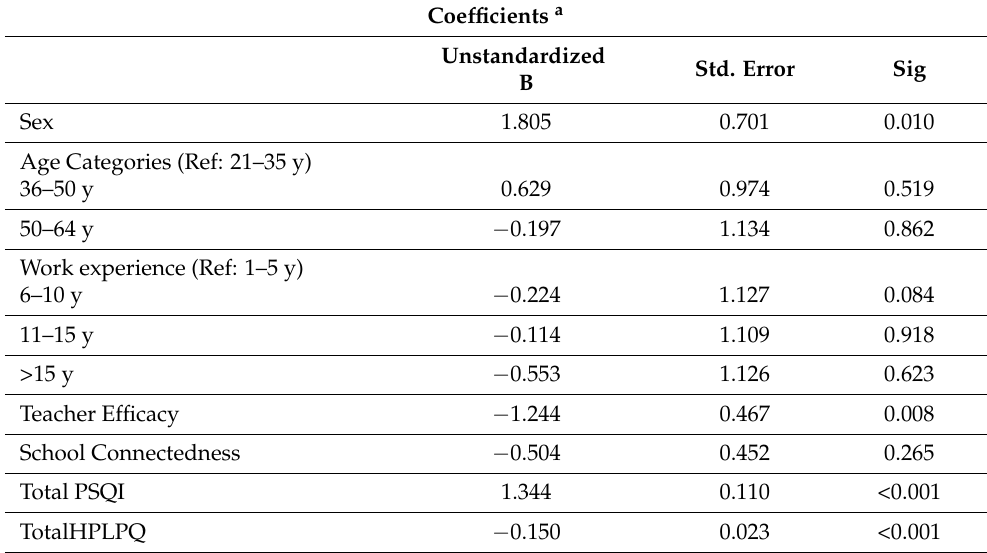
Table 4. Results from multivariate linear regression analyses that evaluated various participants’ characteristics as determinants of